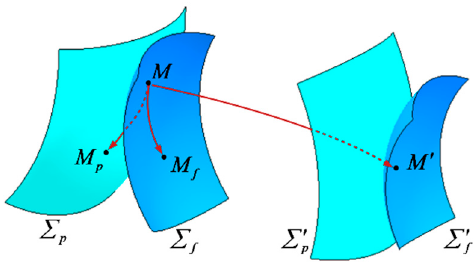
Figure 8. Relative sliding of tooth surfaces.